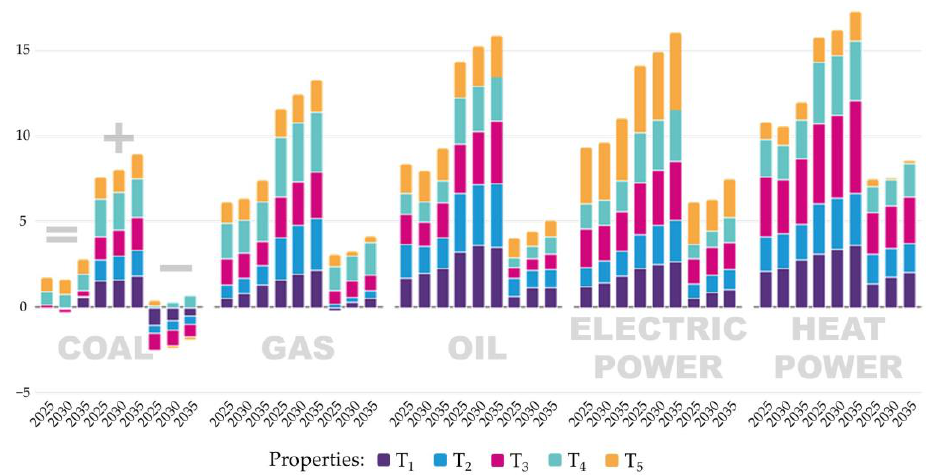
Figure 8. Industry’s scenario coefficients of the development of properties of the LFEC of Middle Volga at three time intervals.